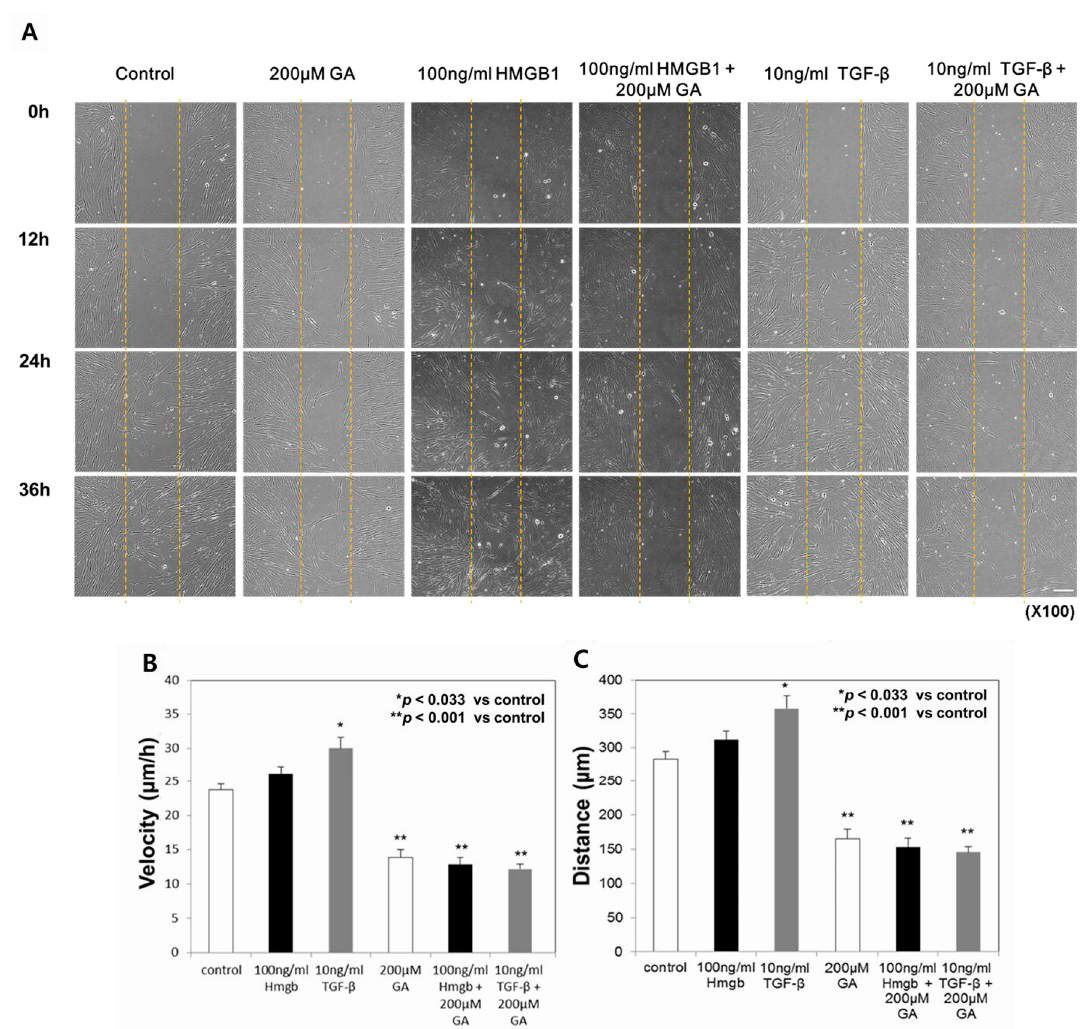
Figure 3. Fibroblast migration was delayed by glycyrrhizic acid (GA) treatment. Scale bar: 50 μ m ( A ) GA induced a decrease in the average migration speed ( B ) and the average distance ( C ) traveled of normal fibroblasts. All results are shown as mean ± SD (* p < 0.033, ** p < 0.001).